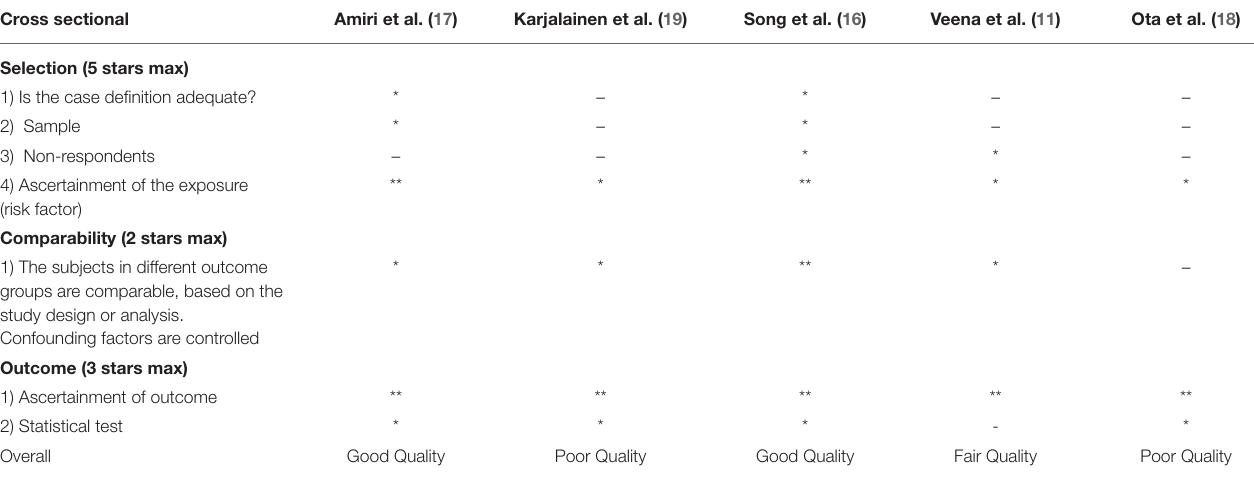
TABLE 2 | Assessment of quality and risk of bias by the Newcastle–Ottawa scale. Cross